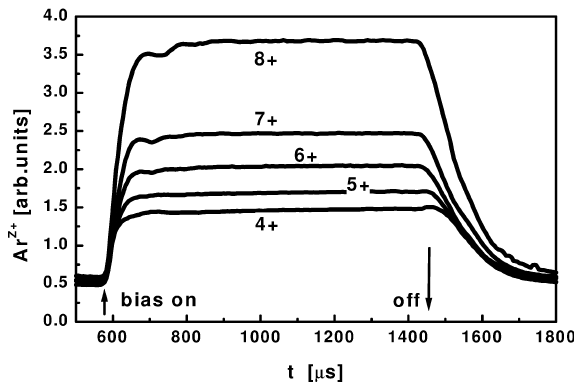
FIG. 3. Time structure of Ar 8 1 ion currents from pure argon plasmas for different amplitudes of the biased-disk voltage. The option with fast rise time (cid:2) 10 m s (cid:3) and slow fall time (cid:2) 100 m s (cid:3) of the pulse generator has been chosen.